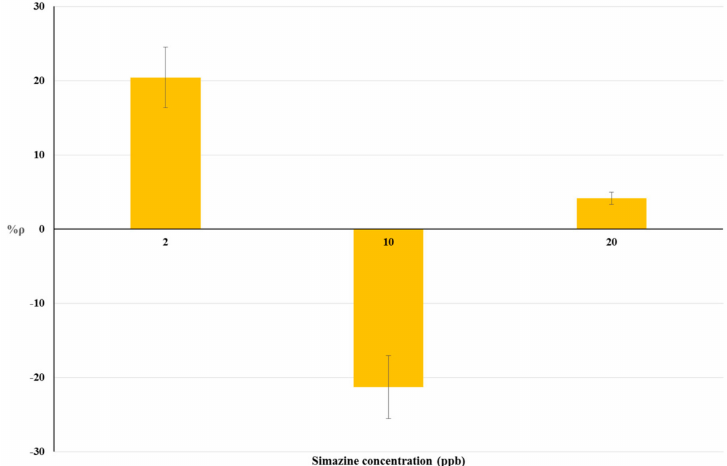
Figure 4. Dose-effect histograms for 2 h exposure to simazine in raw cow’s milk samples. %RSD ≤ 15%; ANOVA testing using Randomized Block Design was applied for statistical differences between means values of ∆ ppm O 2 exp and ∆ ppm O 2 blk ( p <